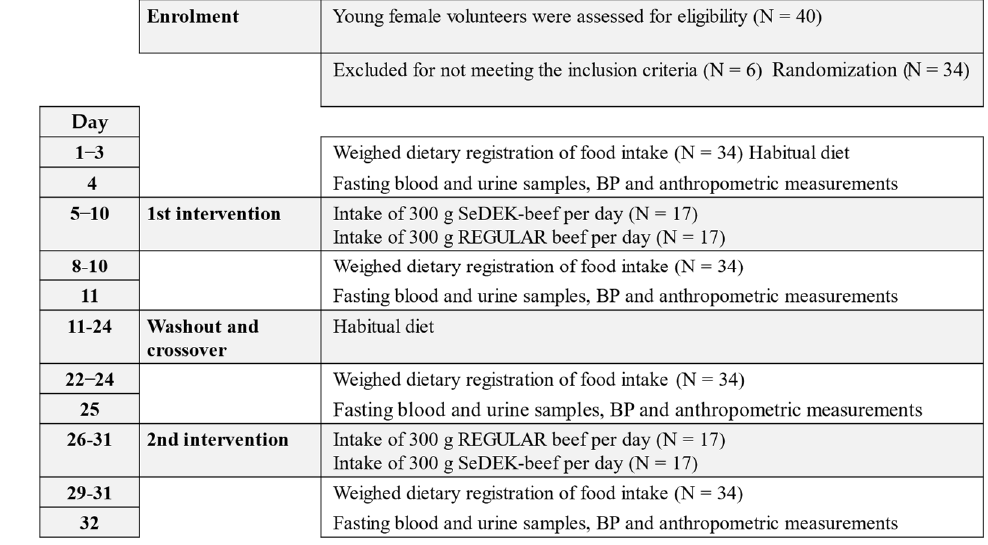
Table 1. Measured nutrient contents in minced beef meat; control bulls (REGULAR) and bulls fed nutrient optimized composite feed (SeDEK) [39]. Reproduced with permission from Kaveri Thaku- ria, Meat Science, Elsevier, 2022.